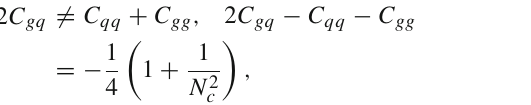
Fig. 3 Diagrammatic representation of A